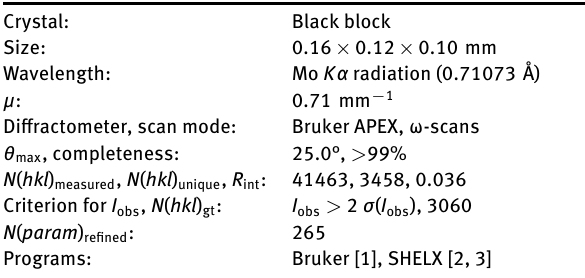
Table 1: Data collection and handling.